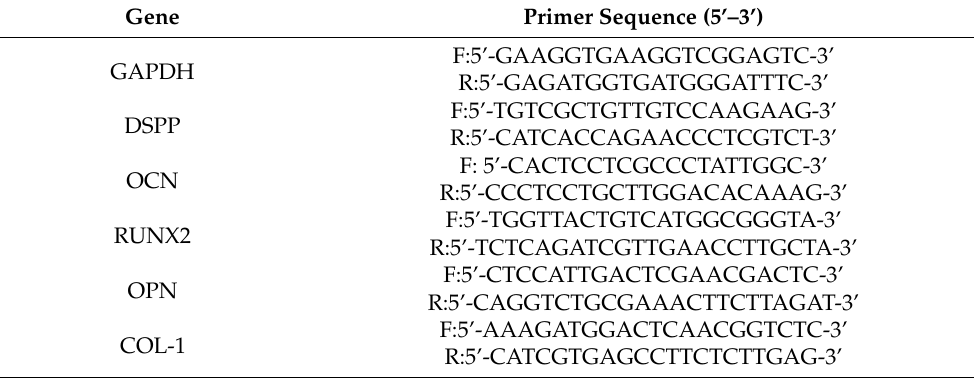
Table 1. Real-time PCR primer sequences of the odontogenesis/osteogenesis-related genes. Gene Primer Sequence (5’–3’)